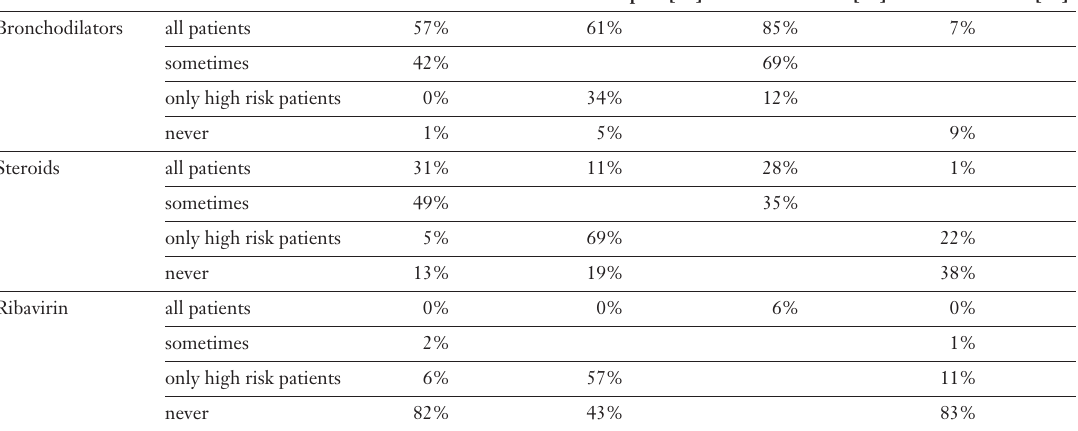
Comparison of the international hospital management of acute